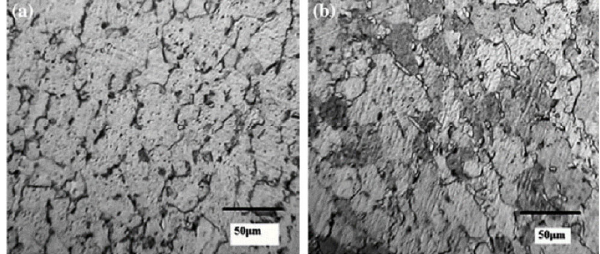
Fig. 3 Metallography images of Ti64 surfaces: (a) as received; (b) ST at 750 ° C (30 min) and quenched in N 2. Reproduced with permission from Ref. [19]. Copyright Springer Nature, 2007.